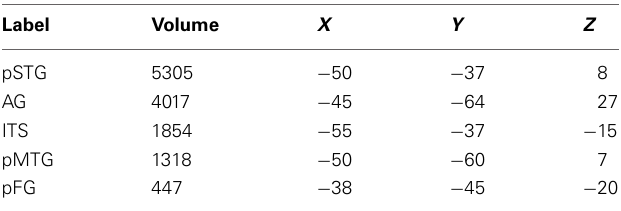
Table 1 | Volumes (in mm 3 ) and center of mass coordinates (in MNI space) for ROIs shown in Figure